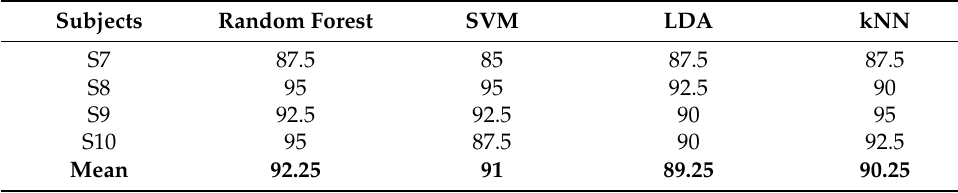
Table 3. Cont. Subjects